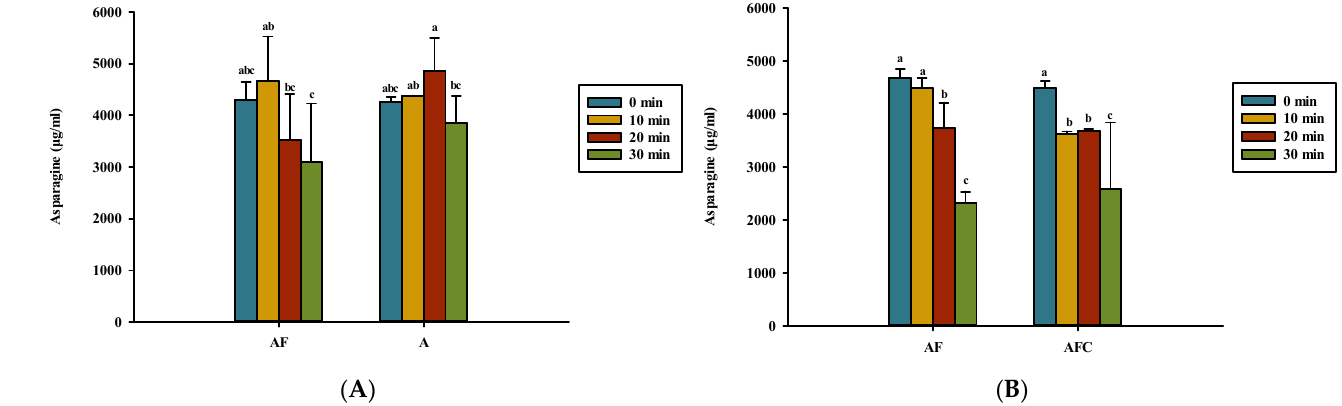
Figure 7. Asparagine content for various groups upon heating in ( A ) water and ( B ) acetic acid. AF, asparagine and fructose; A, asparagine; AFC, asparagine, fructose, and chitosan. Data represent the means of three replicates, and error bars indicate standard deviation. Bars followed by a common letter are not significantly different according to the Dunn’s test at the 5% level of significance.